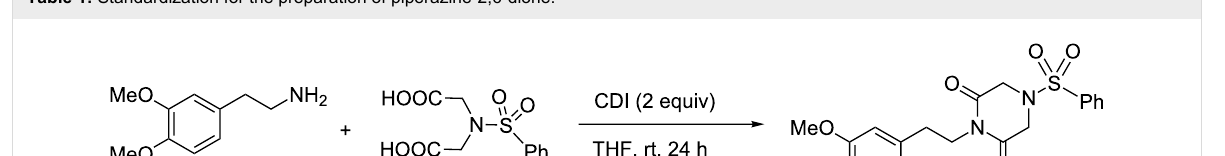
Table 1: Standardization for the preparation of piperazine-2,6-dione.